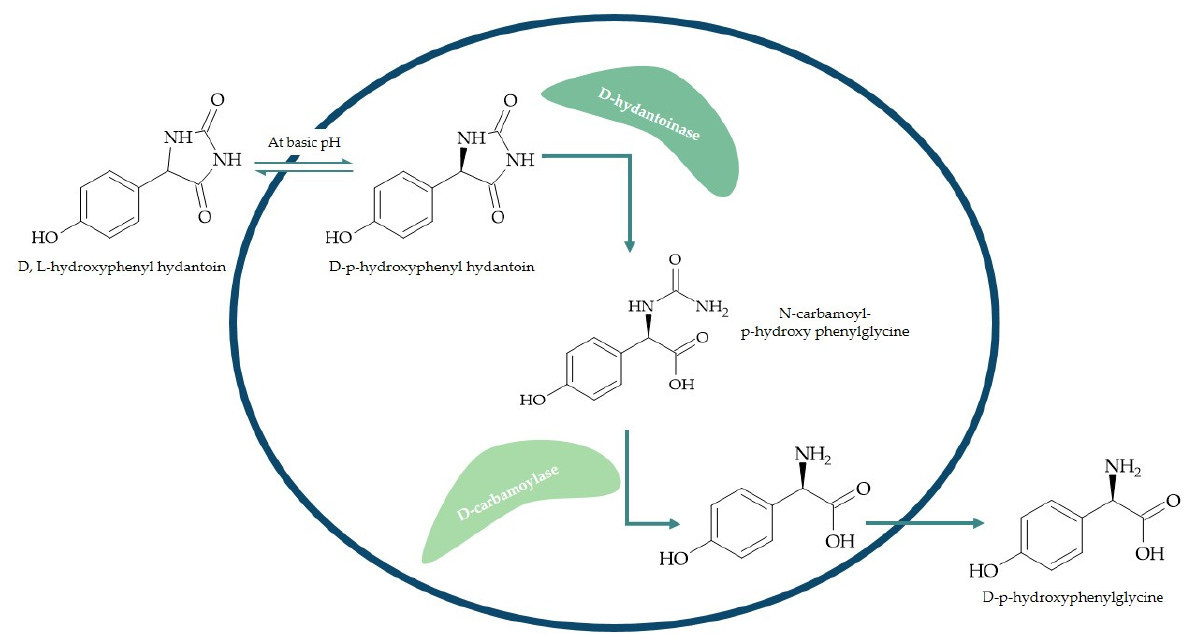
Figure 3. Hydantoinase process developed by Aranaz et al., 2015 [79].